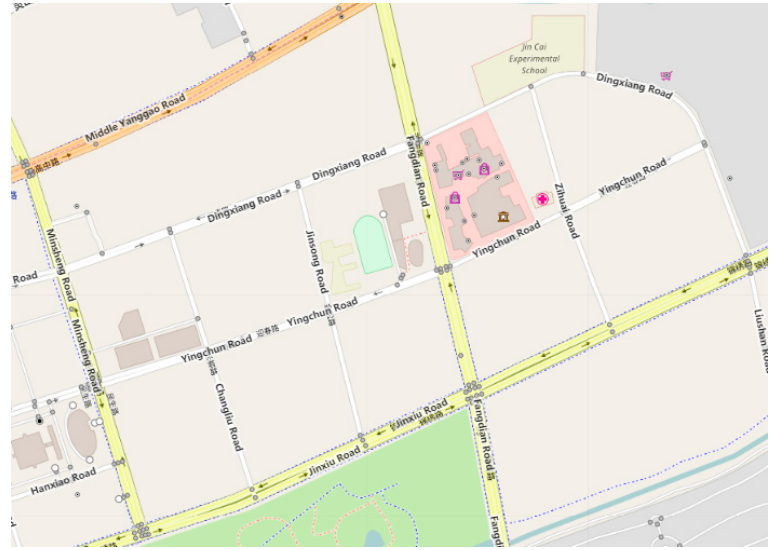
Figure 2. OpenStreetMap (OSM) map of Shanghai Century Park area.